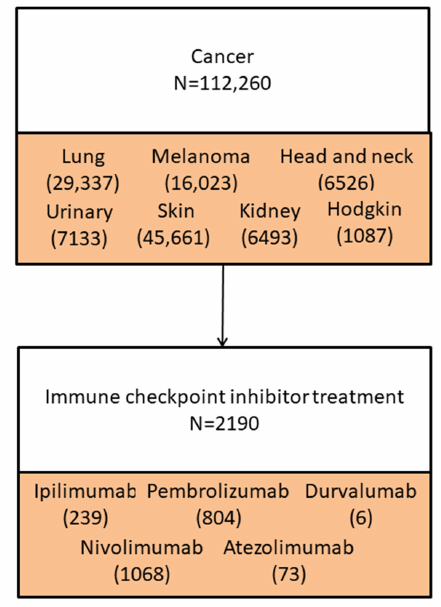
Figure 1. Inclusion of the study population. Table 1. Characteristics of patients with cancer at time of diagnosis.